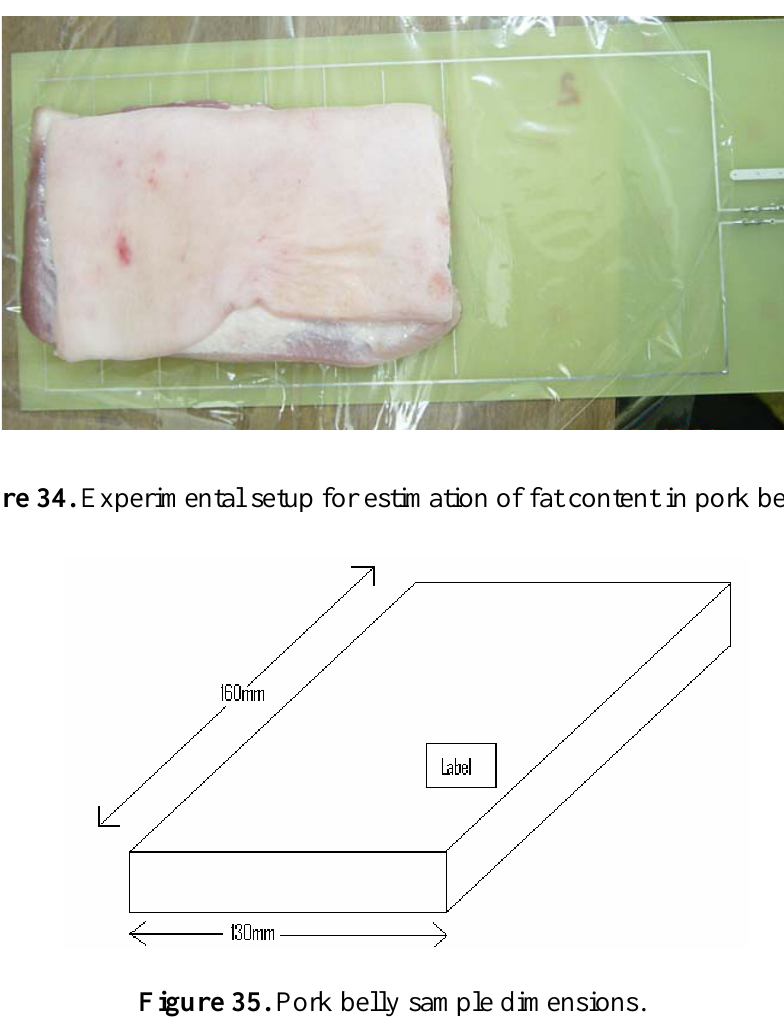
Figure 35. Pork belly sample